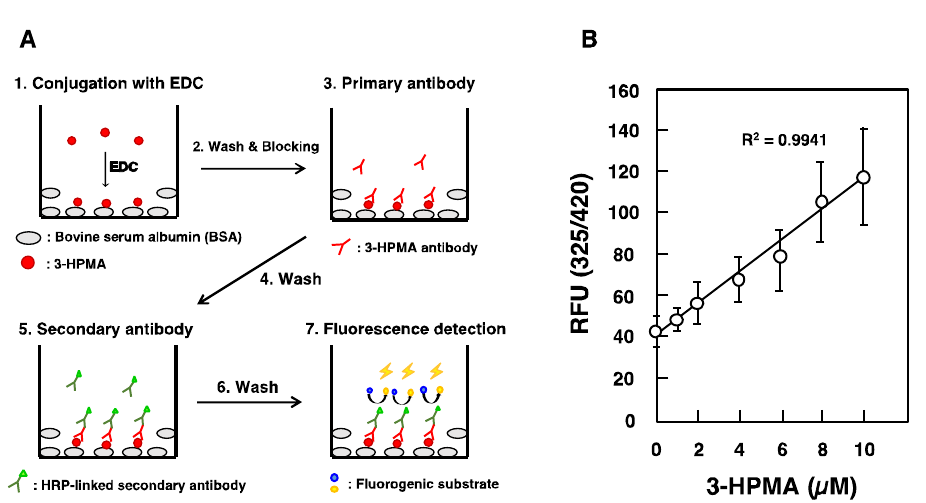
Figure 1. Measurement of 3-hydroxypropyl mercapturic acid (3-HPMA) by enzyme-linked immunosorbent assay (ELISA). ( A ) Schematic presentation of 3-HPMA measurement: 1. Two micrograms of bovine serum albumin was added to each well, and kept overnight at 4 °C. 3-HPMA (0 to 10 μM) in 0.1 mL MES [2-( N -morpholino)ethansulfonic acid] buffer (0.1 M MES, 0.9 M NaCl,